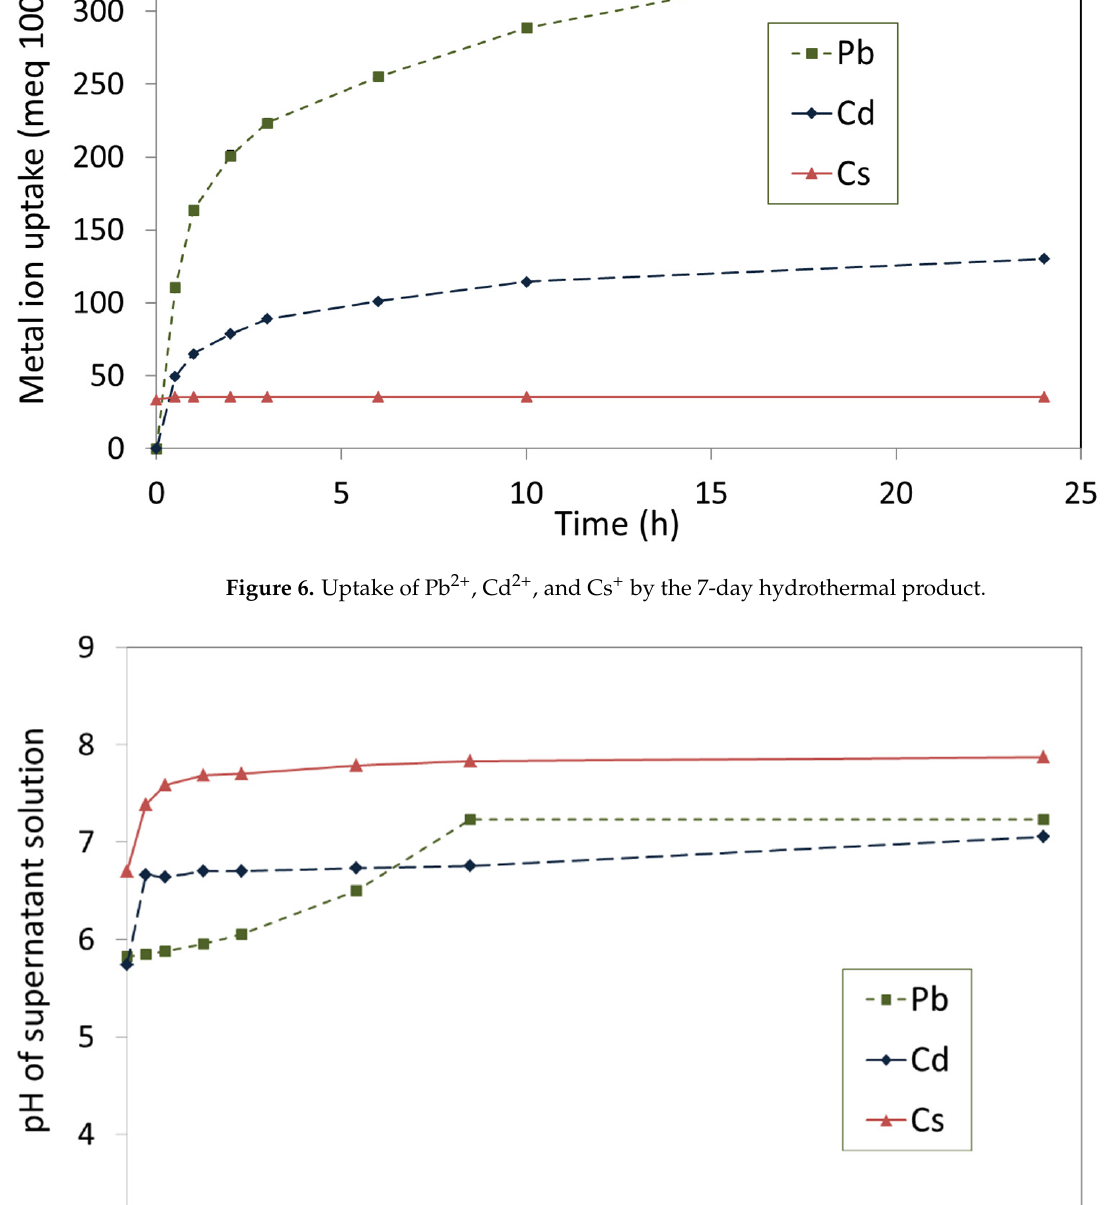
Figure 7. pH of supernatant liquors in contact with the 7-day hydrothermal product (TOB-7). Experimental data for the uptake of Pb 2+ , Cd 2+ , and Cs + by TOB-7 were fitted to the pseudo-first- and pseudo-second-order rate models by least squares regression